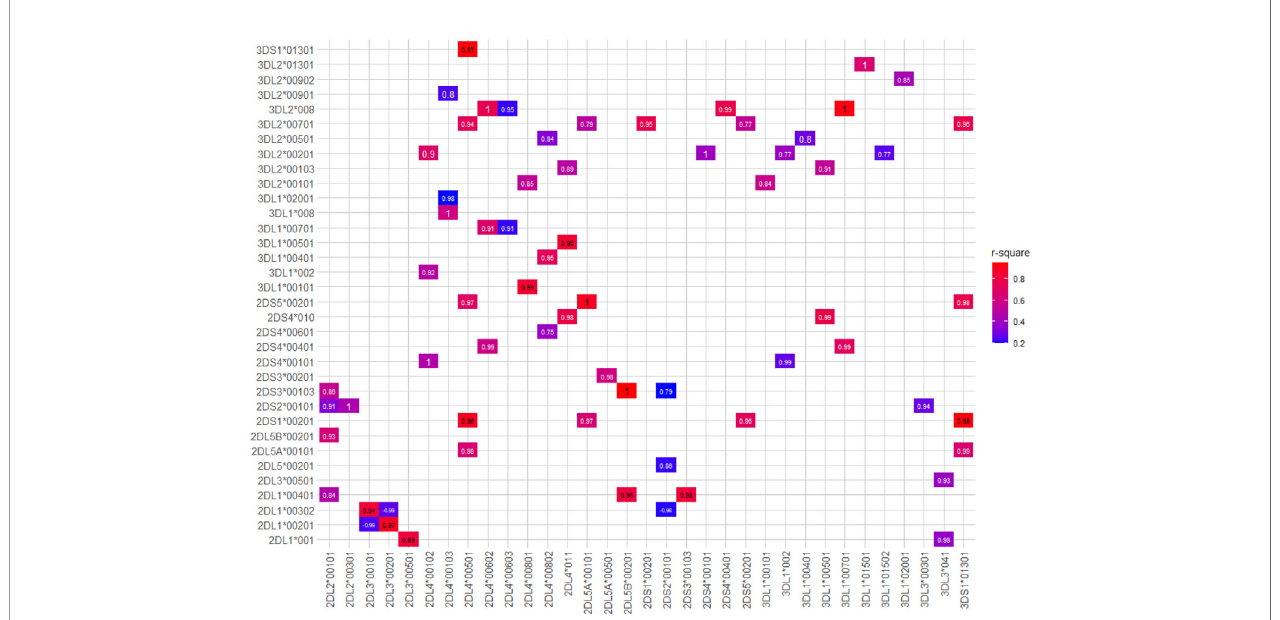
FIGURE 7 | Strong linkage disequilibrium (LD) between KIR alleles. Boxes represent the pairs of KIR alleles with the strongest LD in the present study. D ’ values are written inside of each box and color scale represent r 2 values. Only pairs with r 2 > 0.2, D ’ > 0.7 were shown. The p -value of all pairs was < 10 -5 .